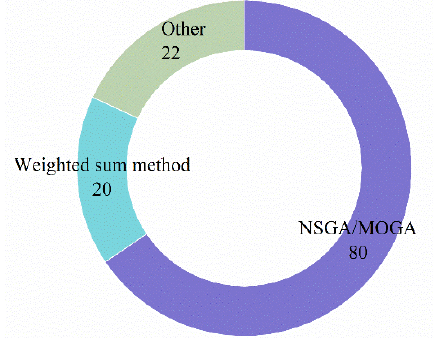
Figure 6. Statistical results of optimization methods.